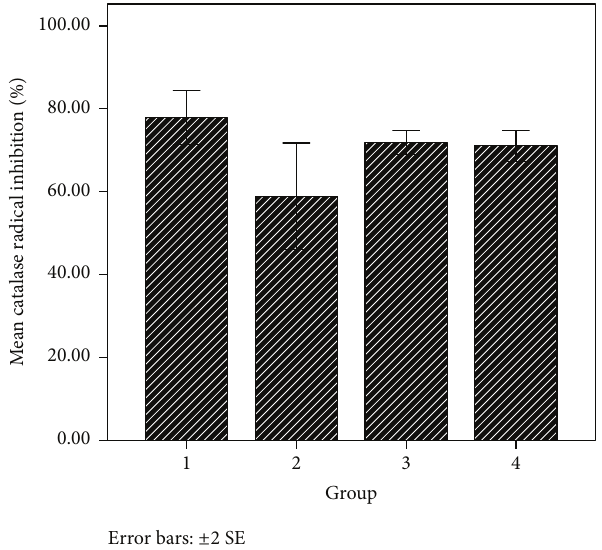
Figure 4: Catalase free radical scavenging potential in various animal groups. Group 1: 6-chloro-11-azabenzo[a]phenothiazine-5- one; group 2: 6-[4-bromophenyl]-10-methyl-11-azabenzo[a]phenot- hiazine-5-one; group 3: ascorbic acid; group 4: solvent.